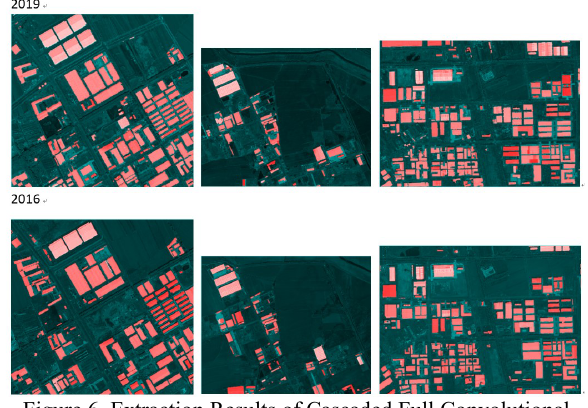
Figure 6. Extraction Results of Cascaded Full Convolutional Neural Networks